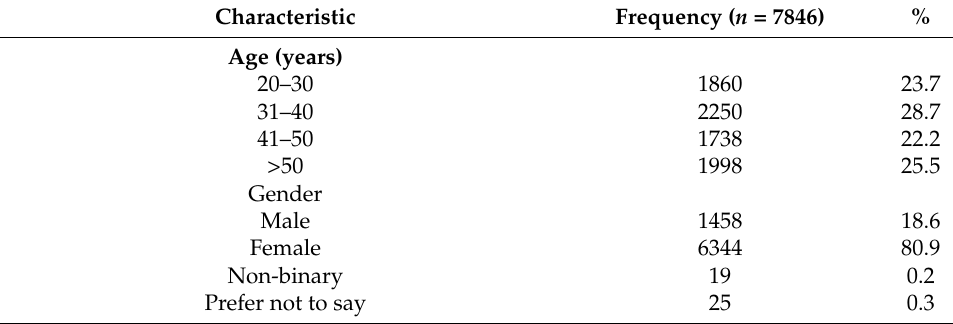
Table 1. Participants’